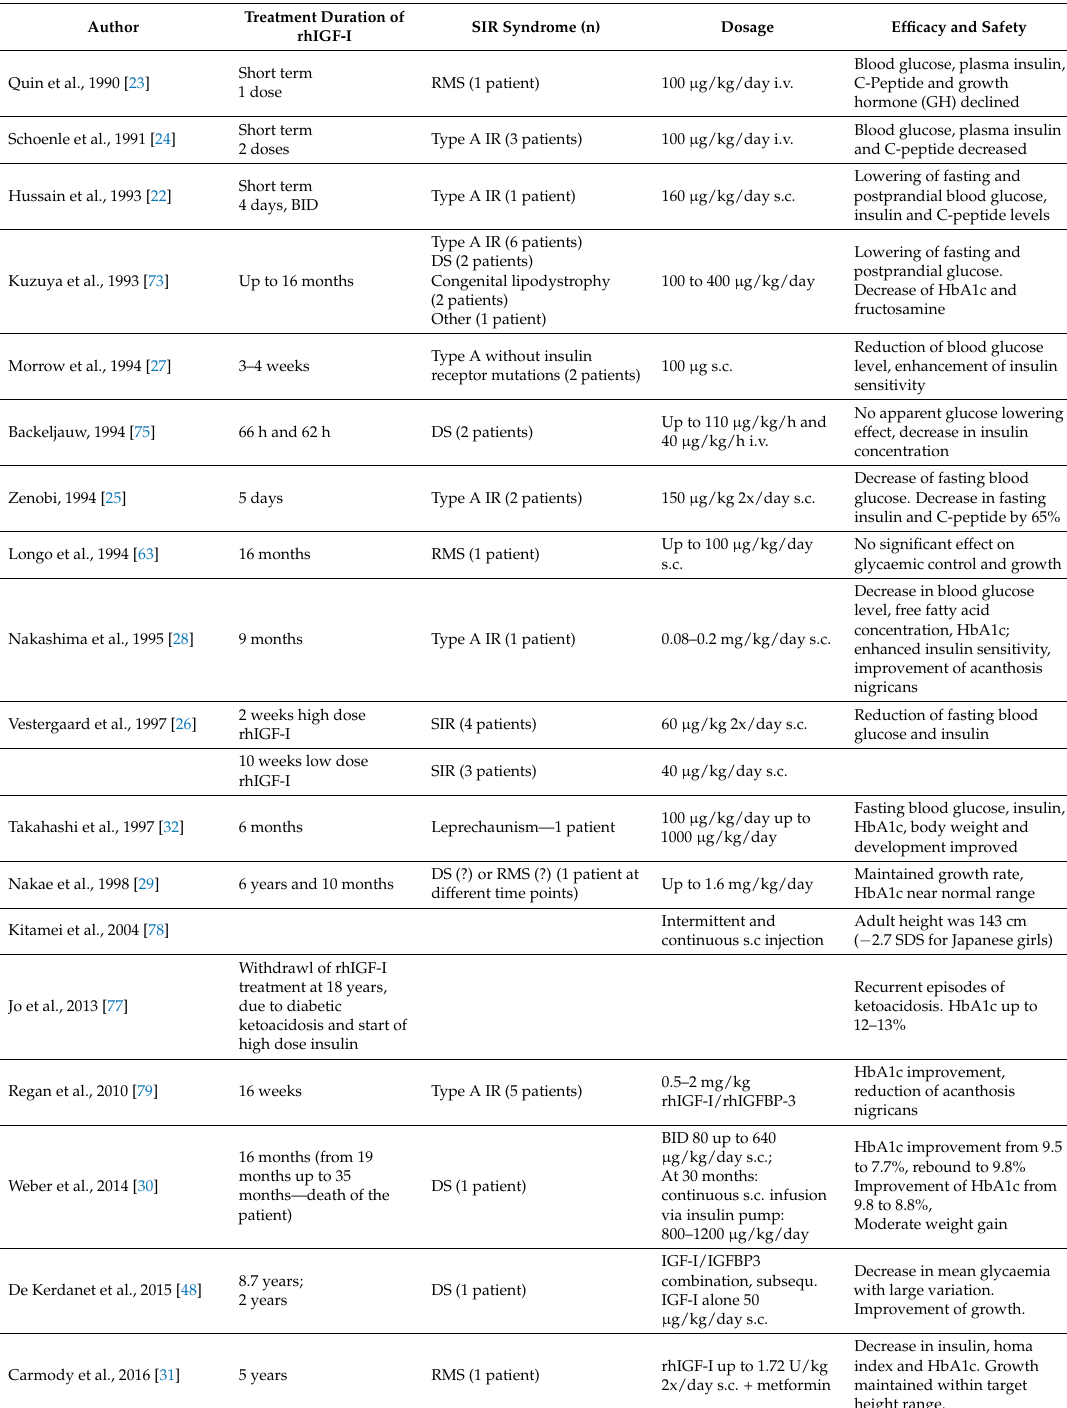
Table 3. Treatment trials with rhIGF-I in patients with severe INSR-related insulin resistance syndromes